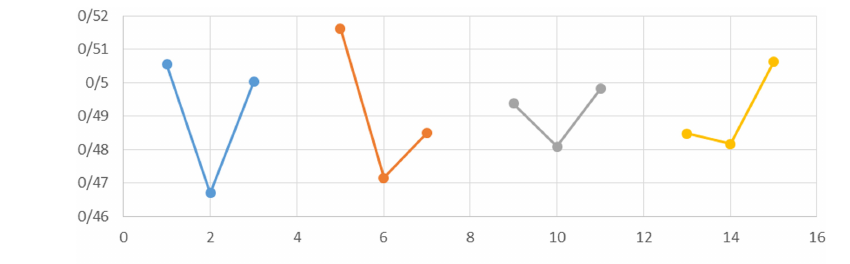
Figure 5. The RPD